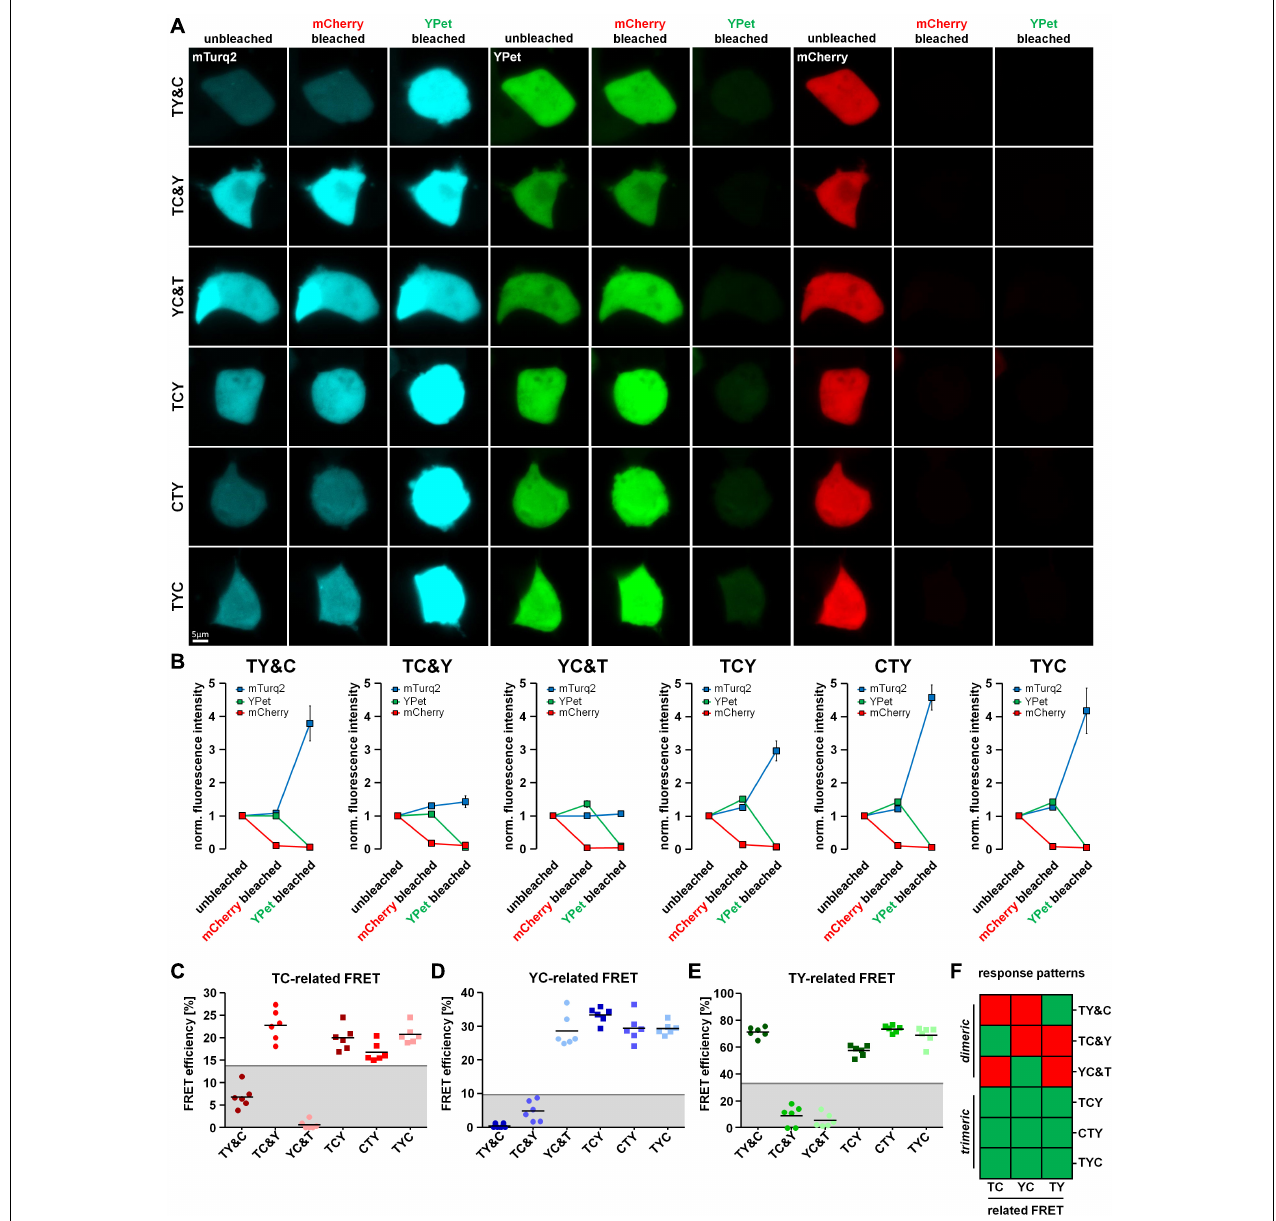
FIGURE 2 | Differentiation of dimeric and trimeric interactions using fluorescence intensity-based measurements. (A) HEK293T cells transfected with either the FRET triplet constructs (TCY, CTY, TYC) or the FRET doublets with their respective missing fluorophore (TY&C, TC&Y, YC&T). Representative images show the fluorescence intensity of mTurquoise2, YPet and mCherry before bleaching (unbleached), after the first bleaching step (mCherry bleached) and after the second bleaching step (YPet bleached). (B) Average fluorescence intensity of mTurquoise2 (mTurq2; blue), YPet (green) and mCherry (red) normalized to the first image acquired ( n = 6). After mCherry bleaching, the YPet fluorescence intensity increased in YC&T, TCY, CTY and TYC and the mTurquoise2 fluorescence intensity increased in TC&Y, TCY, CTY and TYC, only. There was no increase in YPet fluorescence intensity in TY&C and TC&Y samples and no increase in mTurquoise2 fluorescence intensity in TY&C and YC&T samples due to the absence of specific YC- and TC-FRET. After YPet bleaching, the mTurquoise2 fluorescence intensity drastically increased in TY&C, TCY, CTY and TYC, whereas the mTurquoise2 fluorescence intensity remained rather constant in TC&Y and YC&T samples due to the absence of specific TY-FRET. The fluorescence increase corresponded to the unquenching of the FRET donor fluorescence intensity after bleaching its respective FRET acceptor, thereby abolishing FRET between them. (C–E) FRET efficiencies calculated from the change in fluorescence intensity of mTurquoise2 [TC-related FRET, (C) ] and YPet [YC-related FRET, (D) ] after mCherry bleaching and the FRET efficiency obtained from the change of mTurquoise2 fluorescence after YPet bleaching [TY-related FRET, (E) ] ( n = 6). Threshold values set to discriminate interaction-specific FRET from non-specific FRET are indicated by gray lines. Note the different response patterns of FRET doublets compared to those from FRET triplets. (F) Color coded response pattern of fluorescence intensity-based measurements. A Yes-response (occurrence of specific FRET) is indicated by a green and a No-response (no or non-specific FRET) is indicated by a red square. According to these patterns, dimeric interactions (FRET doublets) can be clearly discriminated from trimeric interactions (FRET triplets).